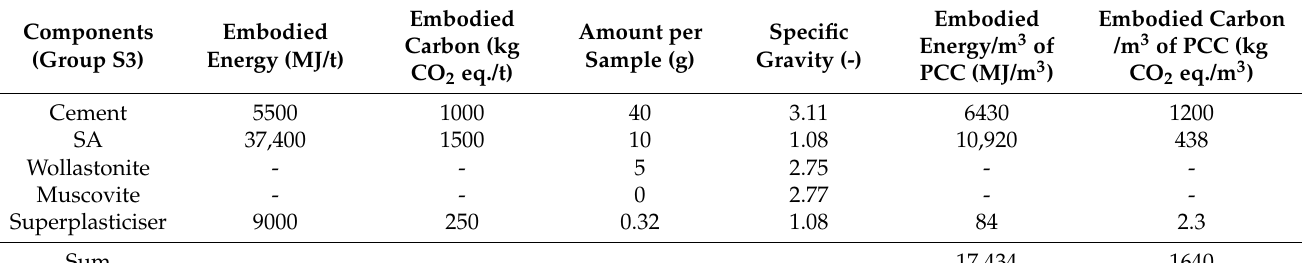
Table 5. GHG emissions and embodied energy of each PCC and its constituents [84–89].